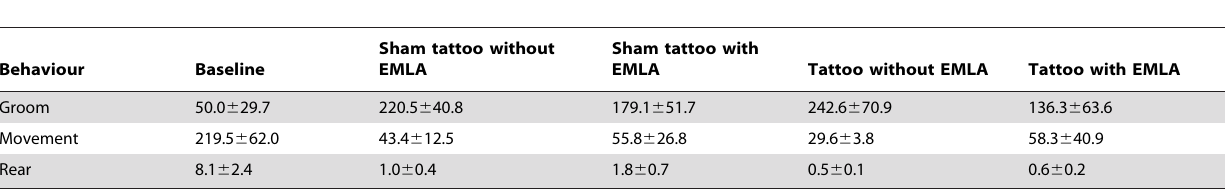
Table 1. The duration of grooming and movement and the frequency of rearing (mean 6 1SE) at baseline compared to 1 hour post each of the four procedures (sham tattoo with/without EMLA & Tattoo with/without EMLA).